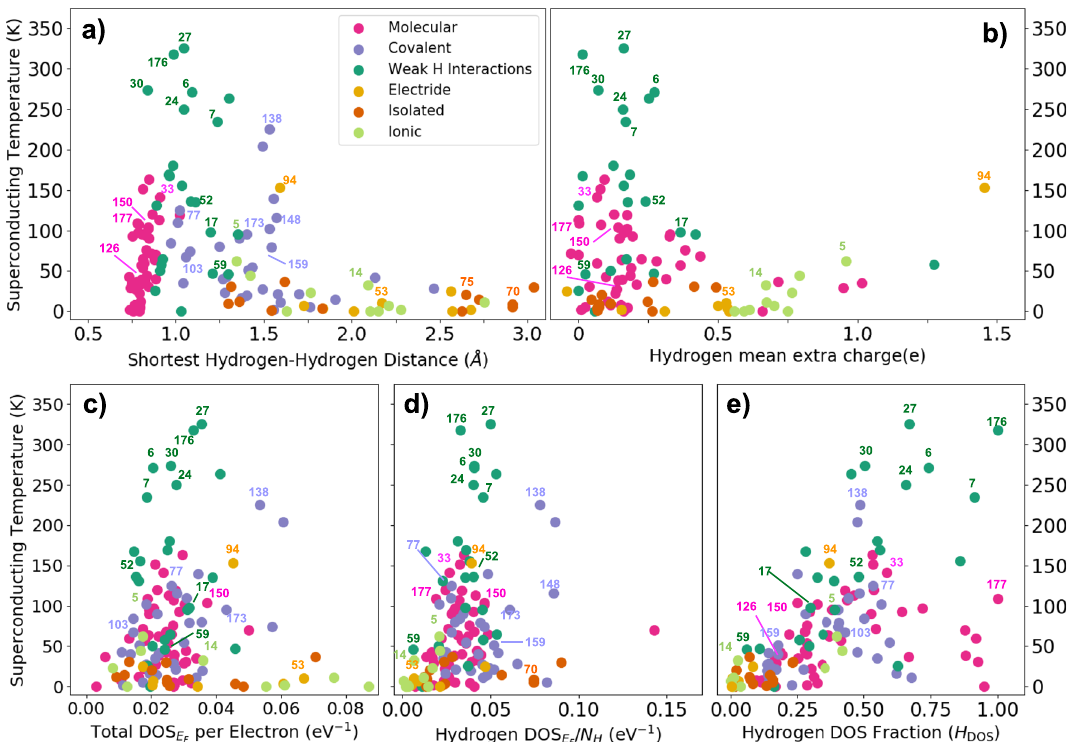
Fig. 2 Structural and electronic properties. Panel a shows T c as a function of the shortest hydrogen – hydrogen distance for all compounds. Panel b shows T c as a function of the mean extra electrons per hydrogen atom. Panels c – e , respectively, show T c as a function of the total DOS at the Fermi level, the DOS at the Fermi level projected on the hydrogen s orbitals per hydrogen, and the fraction of the total DOS at the Fermi level coming from the hydrogen orbitals.